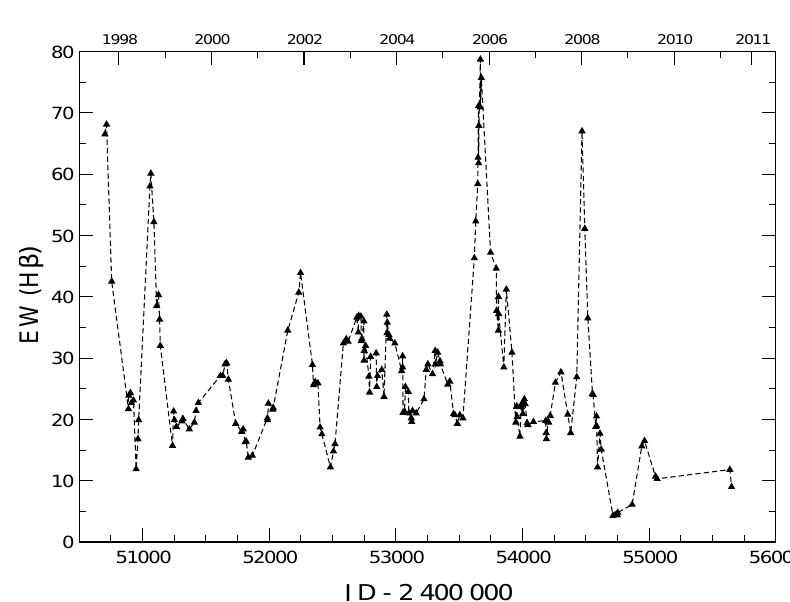
Fig. 3. EWs of the H (cid:12) line in the spectrum of AG Dra in 1997{2011.